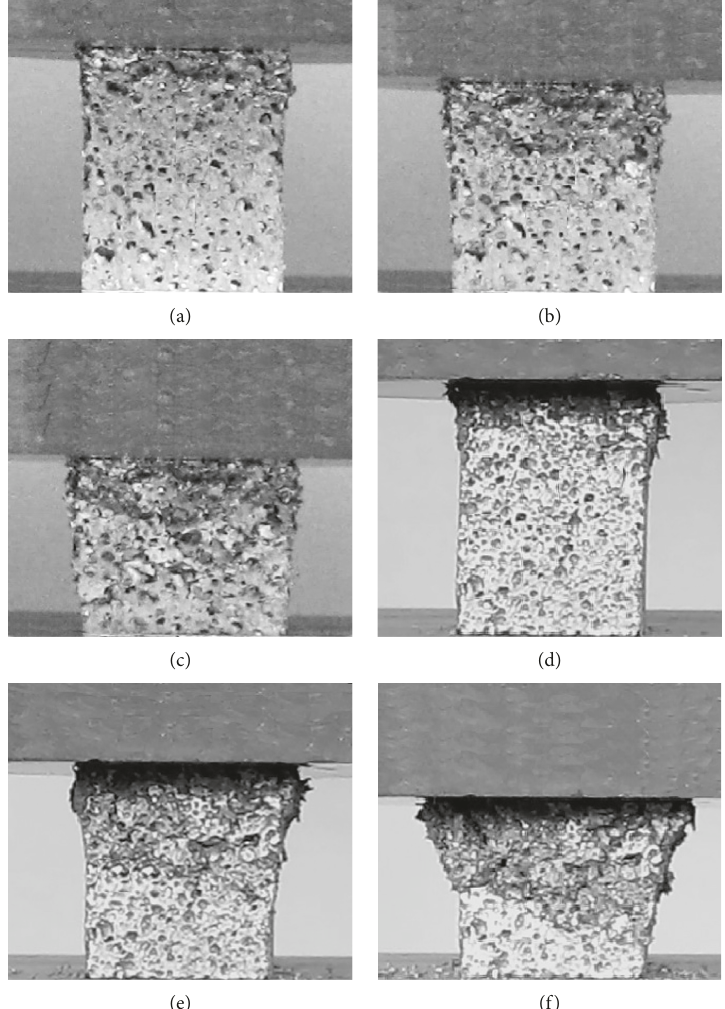
Figure 5: Microphotographs of (a)–(c) Al foam F1 and (d)–(f) Al foam F2, both deformed under the strain rate of _ ε � 10 − 2 s − 1 to different nominal strains: (a) and (d) ε � 0.05; (b) and (e) ε � 0.2; (c) and (f) ε �